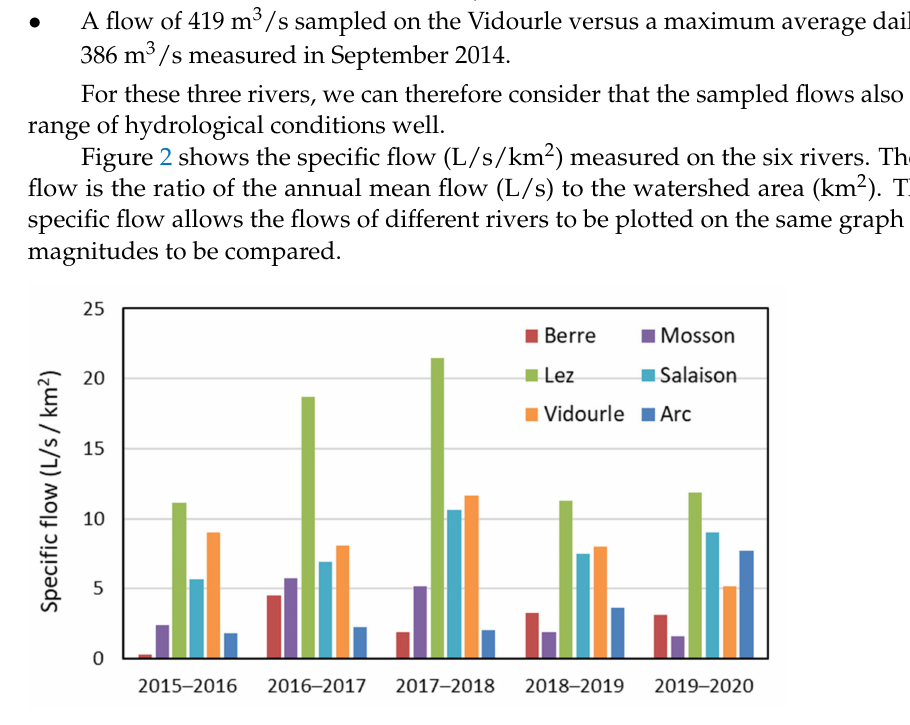
Figure 2. Specific flow (L/s/km 2 ) observed on the six